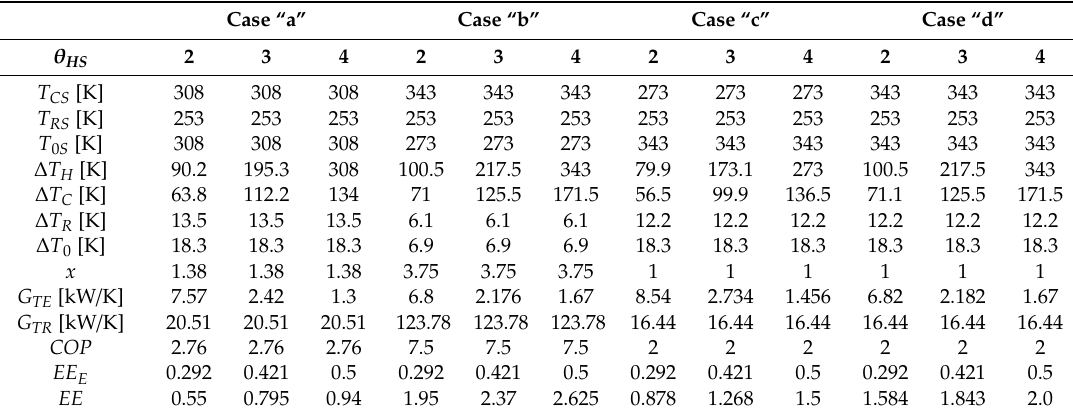
Table 3. Numerical results of the trigeneration system